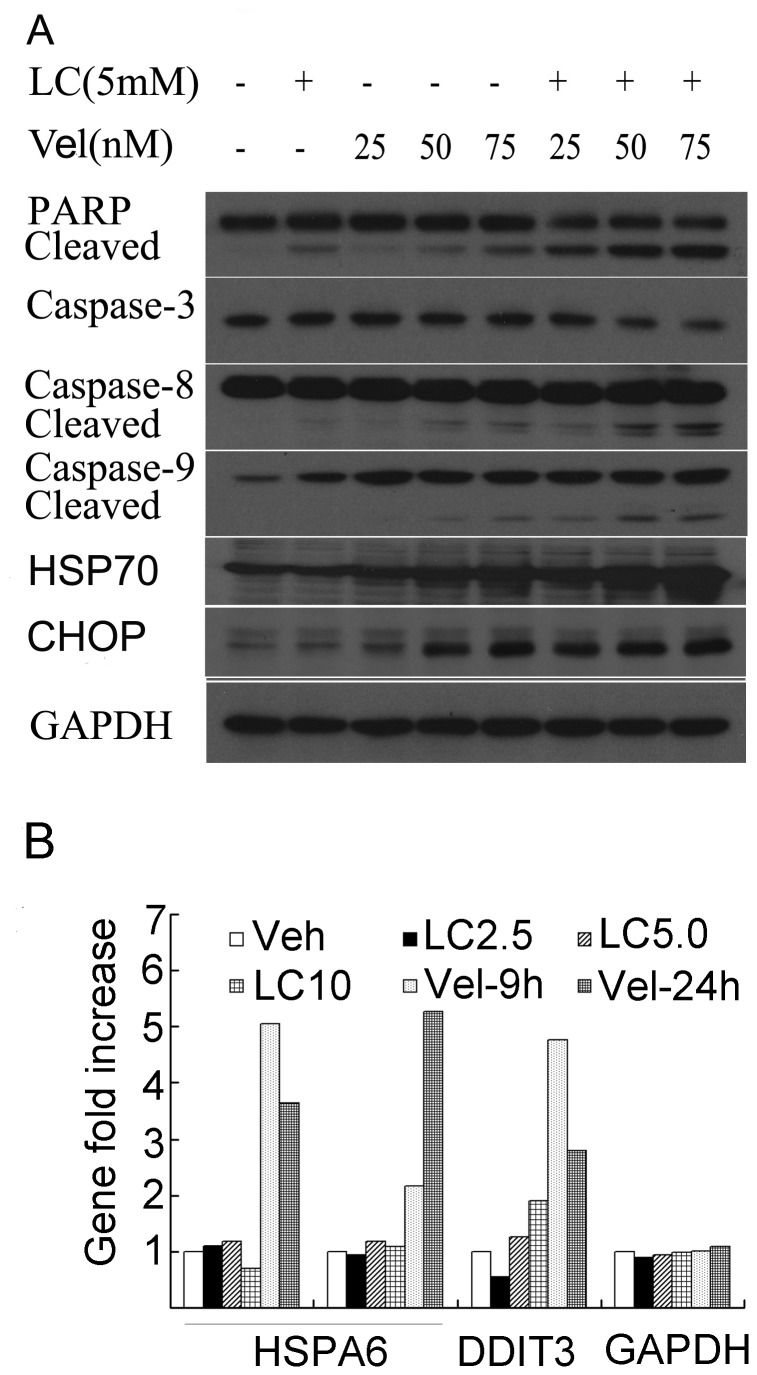
LC and Vel synergistically induces ER stress and caspase activation.(A) HepG2 cells were treated with LC (5 mM), Vel (25, 50, 75 nM) and the combination of them for 24 h. Western blot was performed for the detection of the related proteins including caspases, PARP and ER-related proteins. GAPDH was used as a loading control. (B) As treated and analyzed in Figure 2A, ER-stress-related gene expression as indicated was shown.